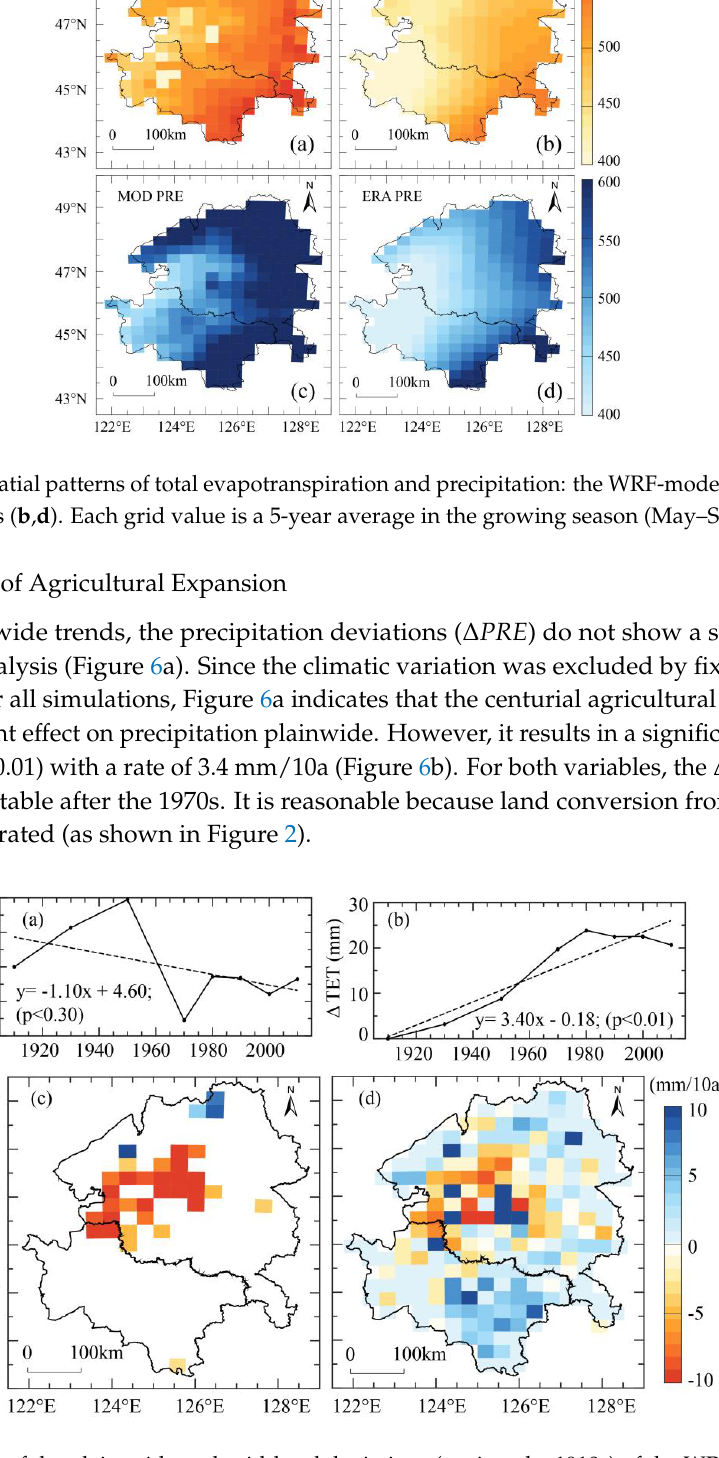
Figure 4. Comparison of the Weather Research and Forecasting (WRF) simulated and European Reanalysis (ERA) Reanalysis of precipitation ( a ) and total evapotranspiration ( c ) in 2008–2012. ( b – d ) are scatterplots of precipitation ( PRE ) and total evapotranspiration ( TET ), respectively.